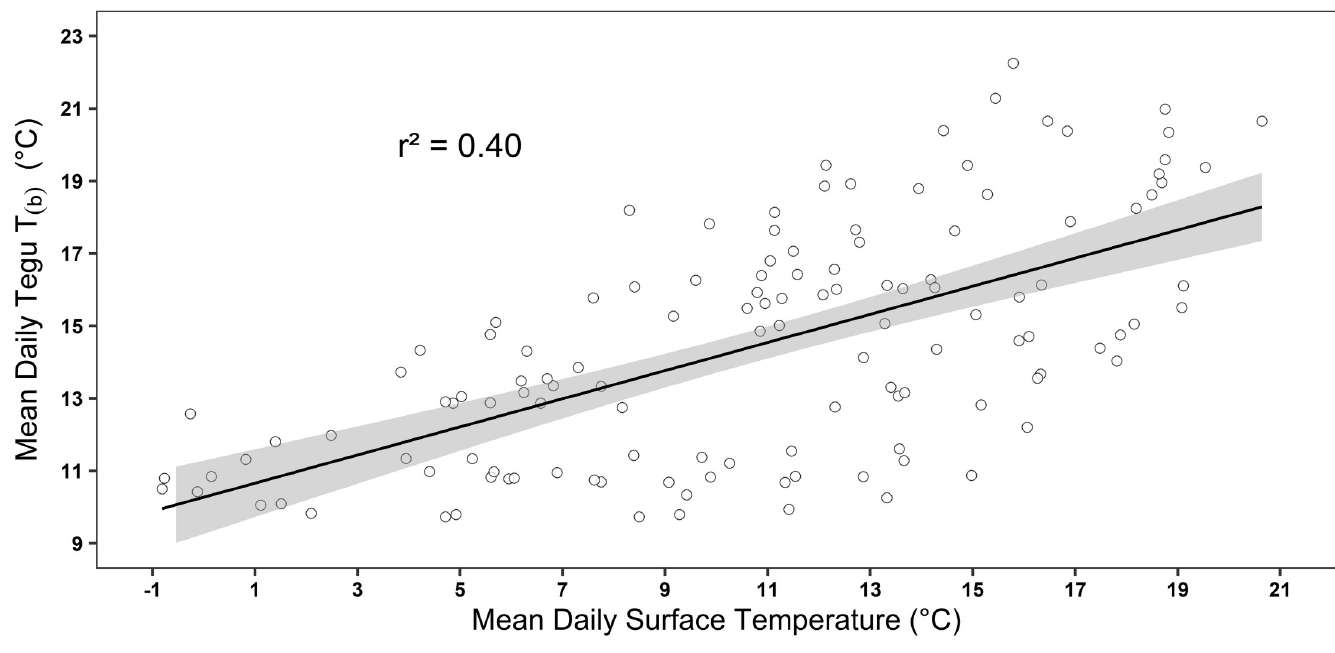
Fig 2. The effect of mean daily surface air temperature on tegu ( Salvator merianae ) mean daily body temperature during hibernation. Tegu mean daily body temperature (black line) surrounded by 95% confidence intervals (gray band) during the dormancy period (17 October 2017–22 February 2018). Each daily temperature (hollow circle) is the average of 11 iButton dataloggers placed in a shaded area of each tegu enclosure and internally implanted in 11 tegus (datalogger malfunctioned in tegu Sm-12).